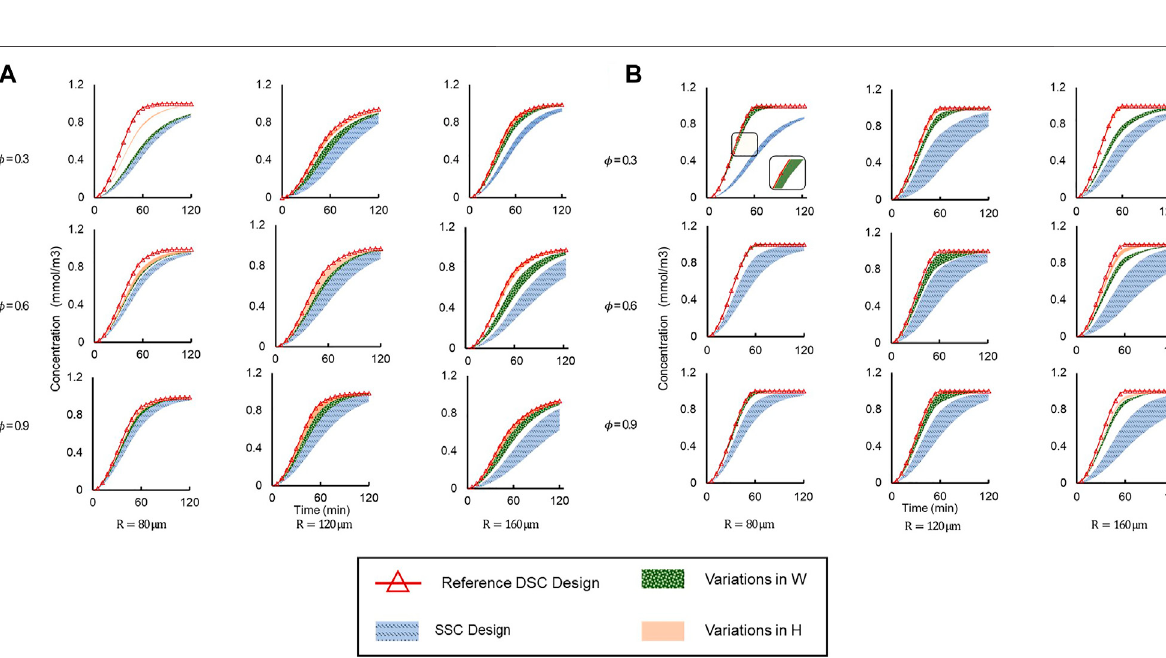
Frontiers in Bioengineering and Biotechnology |